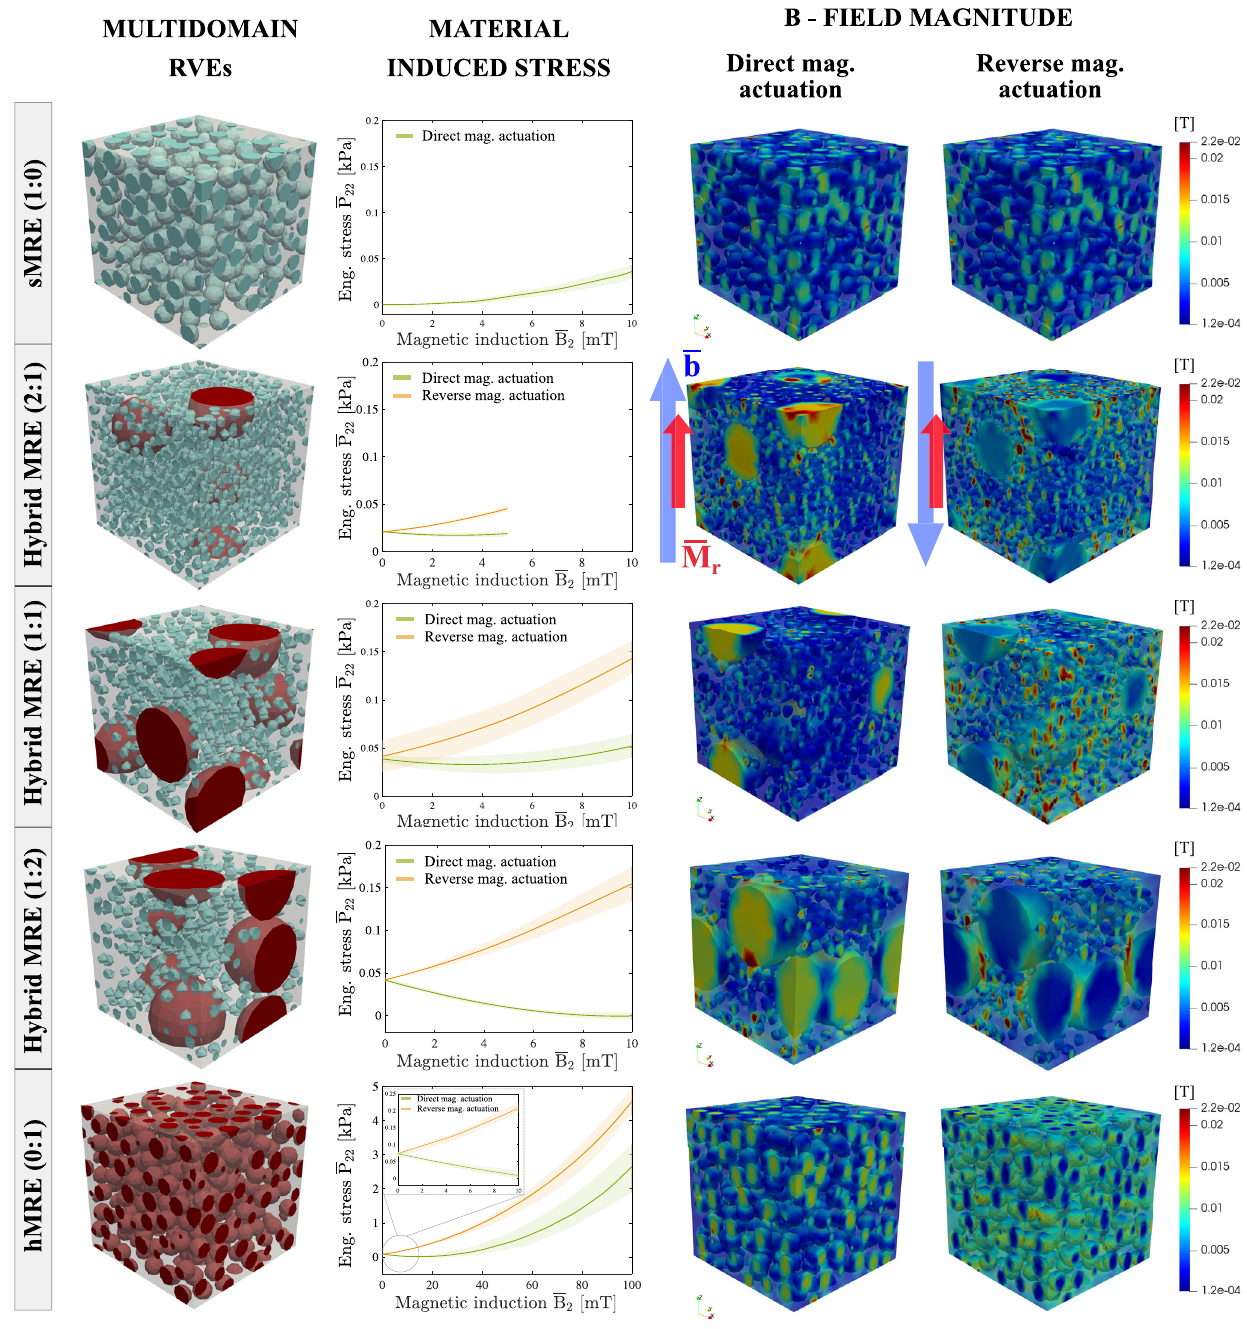
Fig. 3 Computational results of the microstructural magneto-mechanical coupling using a homogenisation model. Computational results for the homogenised framework when subjecting different representative volume elements (RVEs) to homogeneous magnetic inductions while applying mechanical con fi nement. The fi rst column shows representative RVEs for the different particle mixing ratios analysed. The second column presents the homogenised stress against the prescribed homogenised magnetic induction for direct and reverse actuations. The last column shows the microstructural distribution of the magnetic induction within the RVEs for direct and reverse actuation for a macroscopic Eulerian magnetic induction of 5 mT. Note that a scheme with two collinear arrows illustrates the directions of the prescribed magnetic induction (blue) and permanent magnetisation (red) vectors for direct and reverse magnetic actuation. In addition, fi ve RVEs have been considered for each particle mixing ratio. The stress versus magnetic induction curves include scatter areas to quantify the numerical variability. Also, note that a representative RVE has been chosen for each mixing ratio in the magnetic induction effective magnetic fl ux, which directly impacts the resultant ones in two ways: (i) amplifying the magnetic fi eld around the microscopic torque transmitted from the hard particles to the hard particles and (ii) compressing the upper layer along the beam matrix. Note that such magnetic pathways appear not only in the thickness. Regarding the former, the soft-magnetic particles, with perpendicular (vertical) direction, but also in the longitudinal a high magnetic permeability, create magnetic pathways around (horizontal) direction. Figure 4.f2 clari fi es this phenomenon. After the hard-magnetic particles. Such a phenomenon increases the